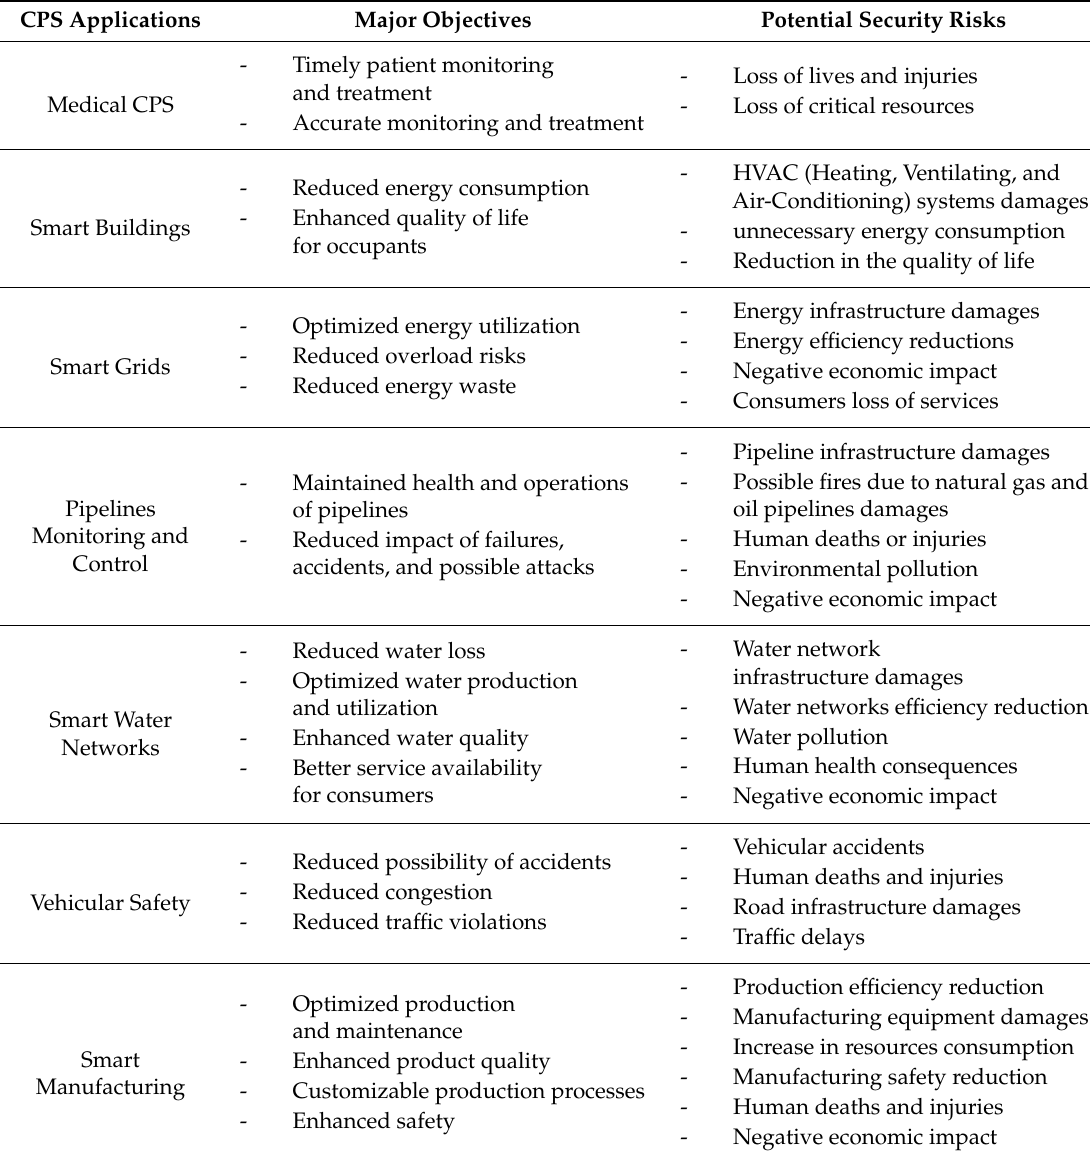
Table 1. CPS Applications Benefits and Potential Security